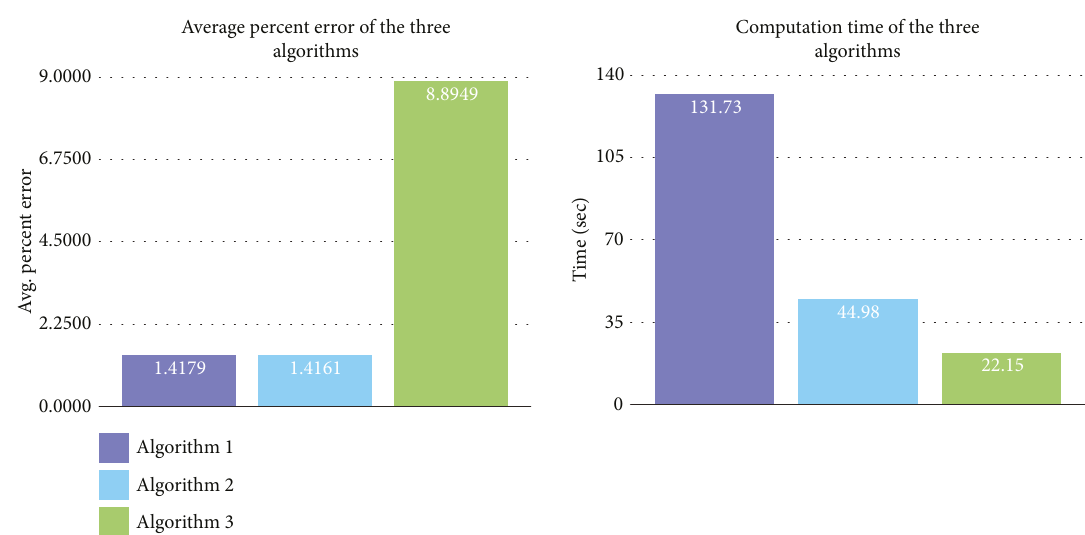
Figure 1: Trade-o ff s of the three versions of the NU-DMD.